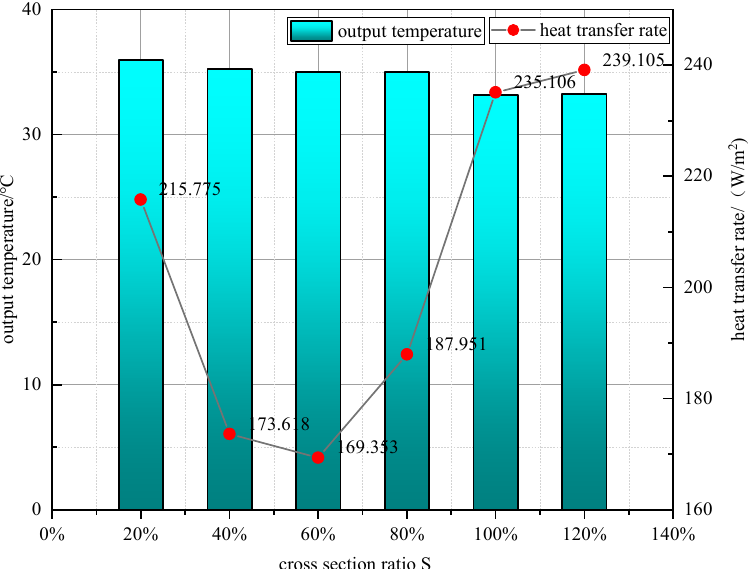
Figure 7. Variation in the outlet temperature and heat flux of wall-mounted solar chimney under different S-values.